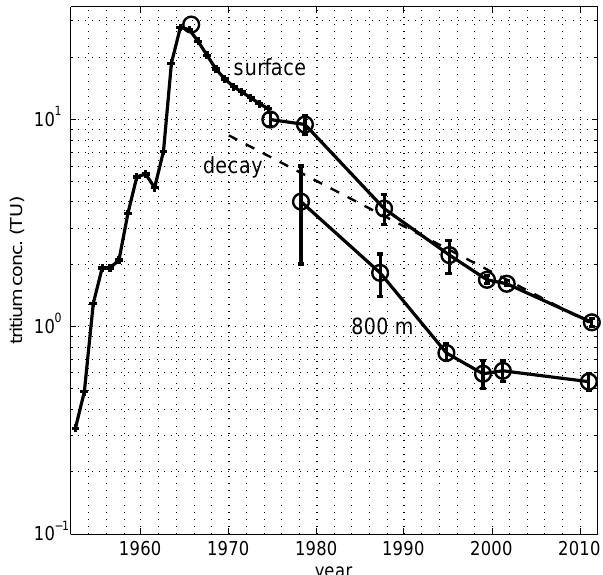
Fig. 1. Tritium concentrations (TU) in the Mediterranean south of Crete vs. time, 1952–2011, at the surface and at 800m depth (see text). Year marks are 1st January. Typically averages of 3 stations are shown (numerical values for surface water in Appendix A). The error bars represent one standard deviation of the apparent scatter between individual values, plus interpolation and estimated mea- surement errors. For the part up to 1974 the uncertainty should not exceed 20%, while that of the pre-nuclear value of 1952 is proba- bly somewhat larger. For reference, tritium decay is shown by the dashed line. The mean concentration during 1952 to 2011 was about 6.7 TU, about 20 times the natural